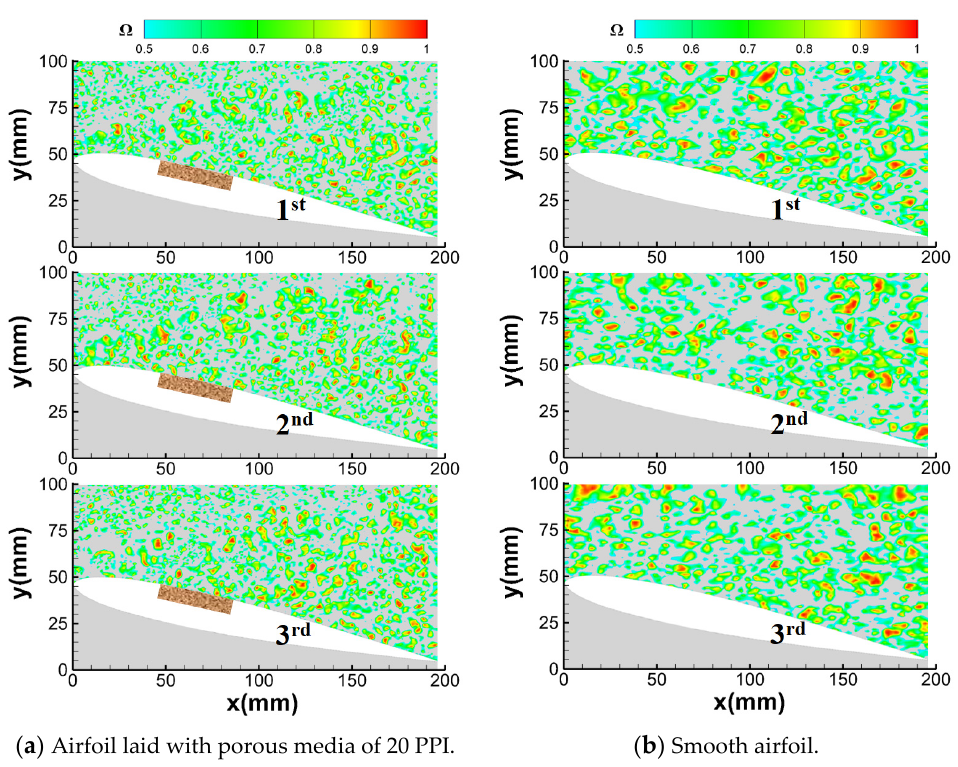
Figure 11. Vorticity contours with Ω criterion.